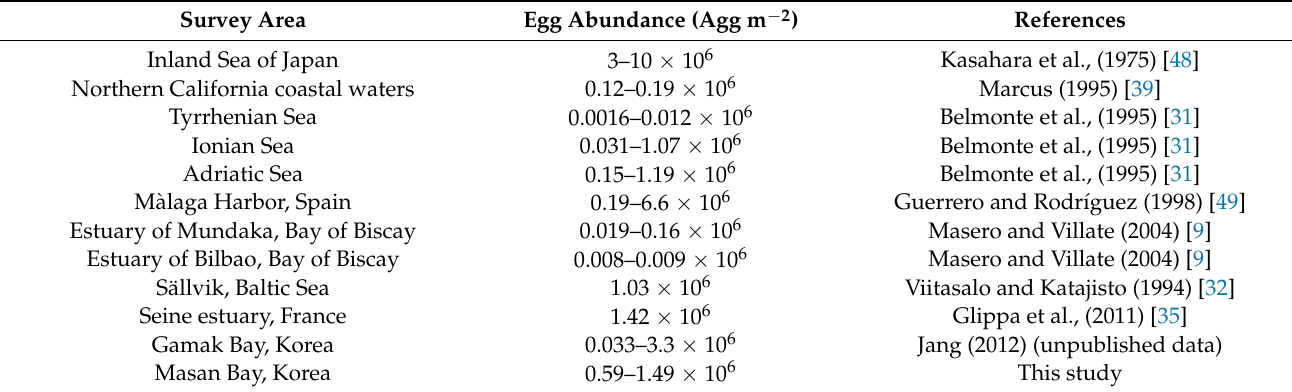
Table 1. Summary of the abundance of copepod eggs in various